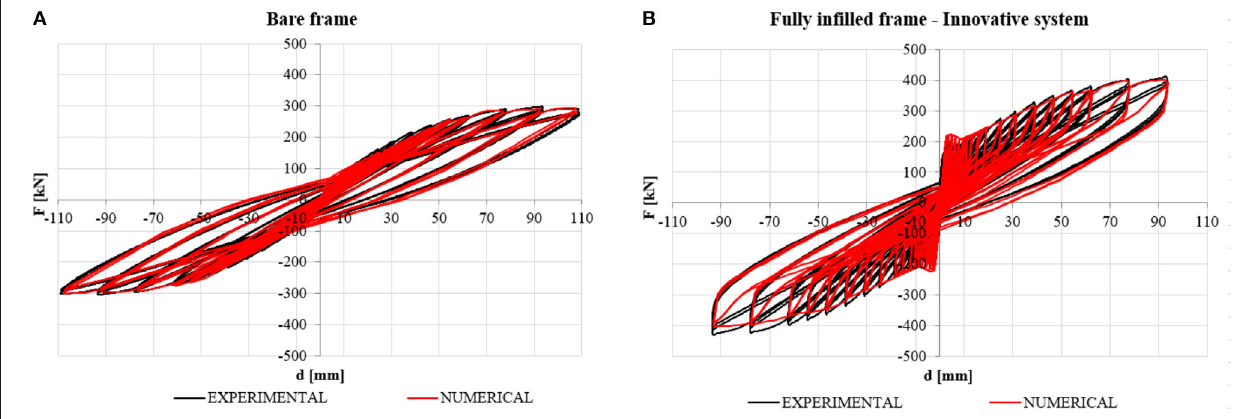
FIGURE 10 | Comparison between the force–displacement experimental and numerical curves. (A) Bare frame. (B) Fully infilled case.